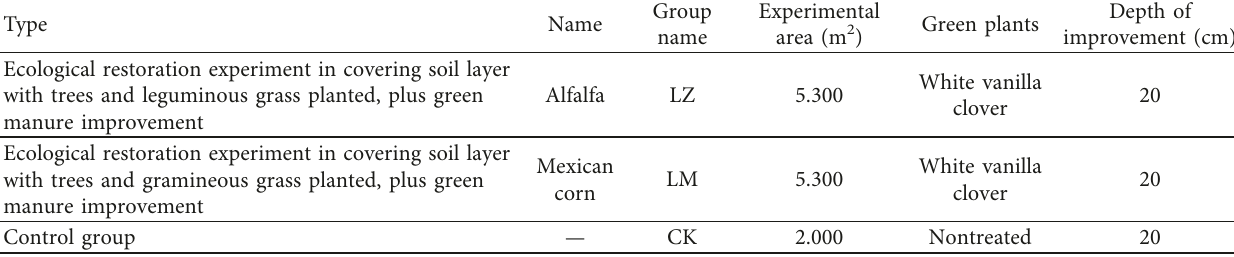
Table 4: Experimental design for green manure improvement in the reclamation area.